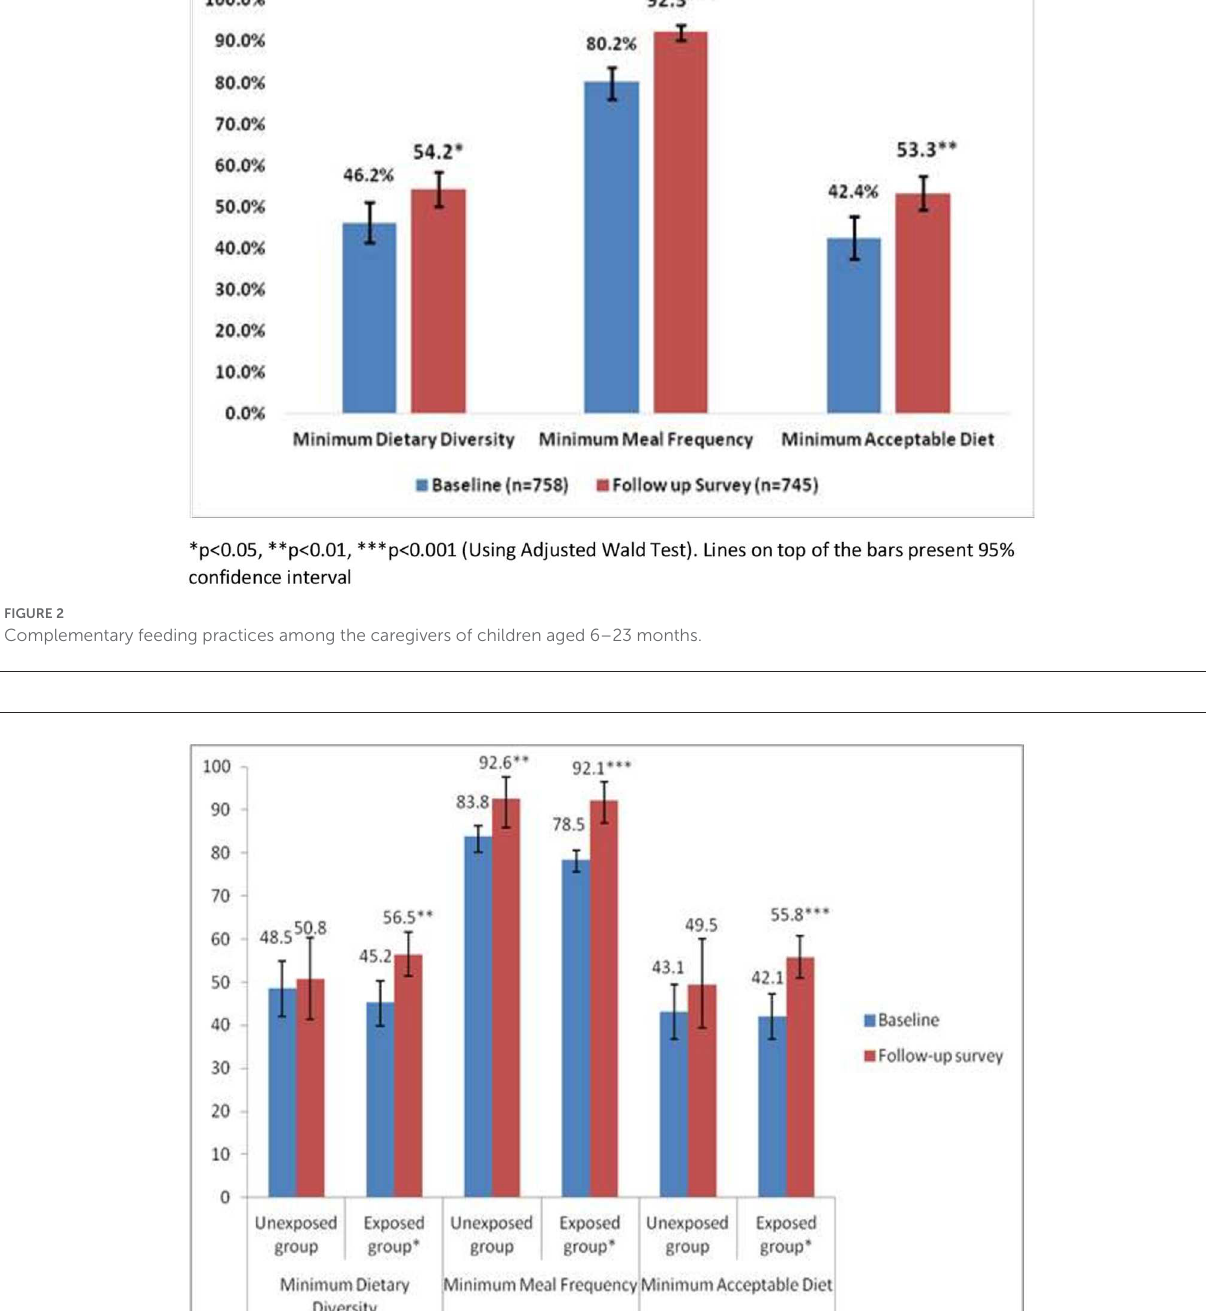
during home visit works. Nevertheless, the caregivers of the children are more likely to listen to those CHWs who are acceptable to them. Evidence shows that acceptancy of the CHWs depends on how they are selected, trained and supervised (21). Another study indicates that in addition to adequate training the implementers